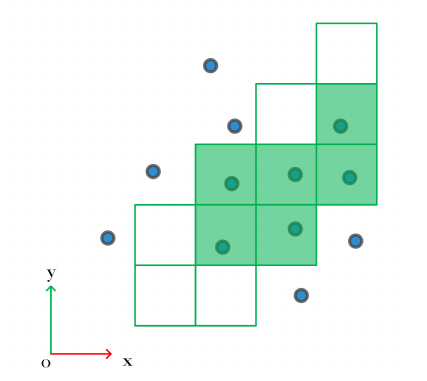
Figure 4: Determination of the area of intersection of two over- lapping point clouds